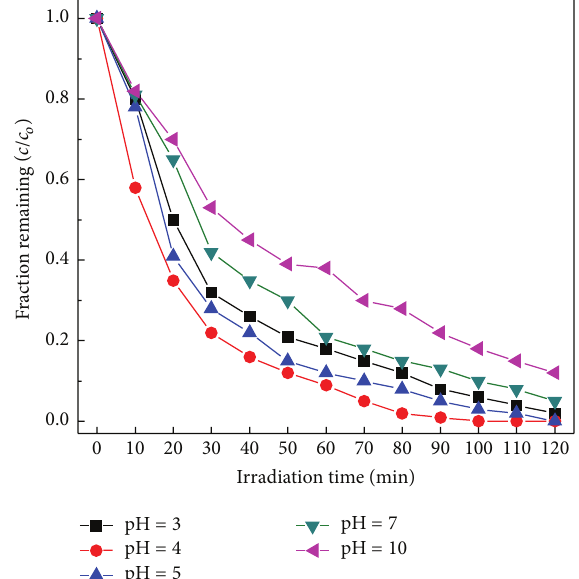
Figure 5: Removal efficiencies of RhB in the presence of 1.2% G- BWO with different catalysts dosage amount under visible light = 10ppm; pH 7; T = 20 ∘ C). irradiation ( c o